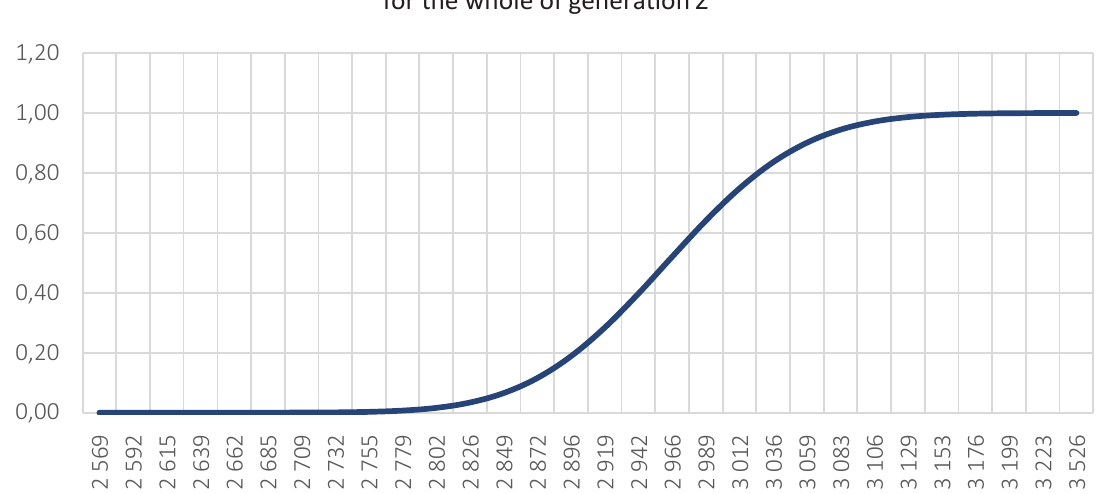
Figure 1. Probability density function of current random value of future compensation for the whole of generation Z